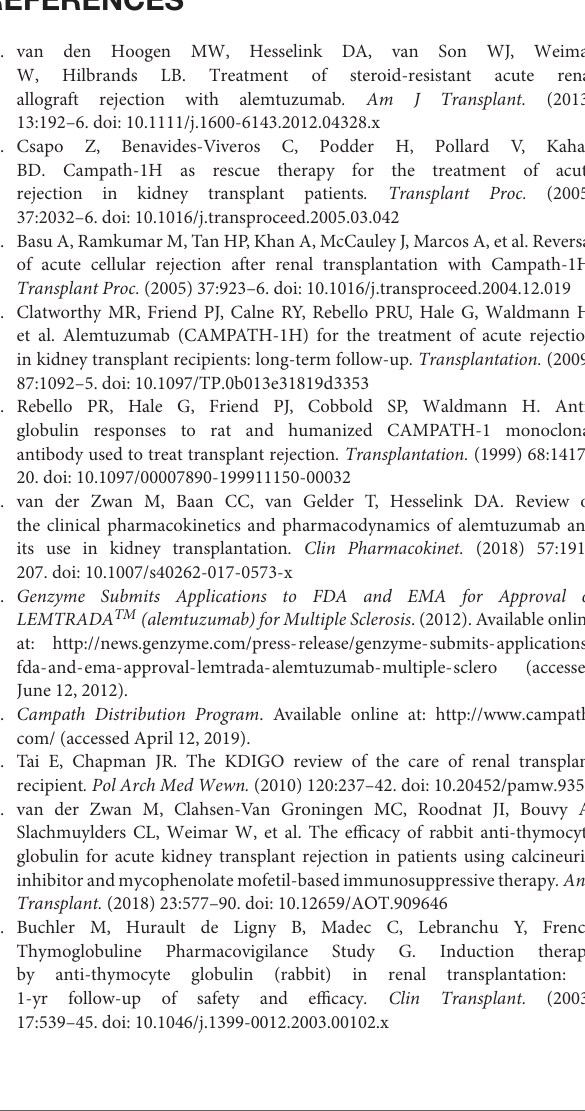
Table S6 | Infections during the total follow-up after alemtuzumab and rATG treatment. Table S7 | Malignancies after alemtuzumab treatment. Table S8 | Malignancies after rATG